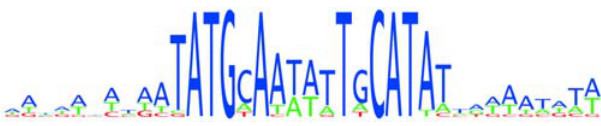
Figure 3. PlcR consensus sequence. The height of the letter representing a base is proportional to its frequency at each position in the alignment. For each position, the most frequent base is drawn in blue, followed by green and pink for less frequent bases.